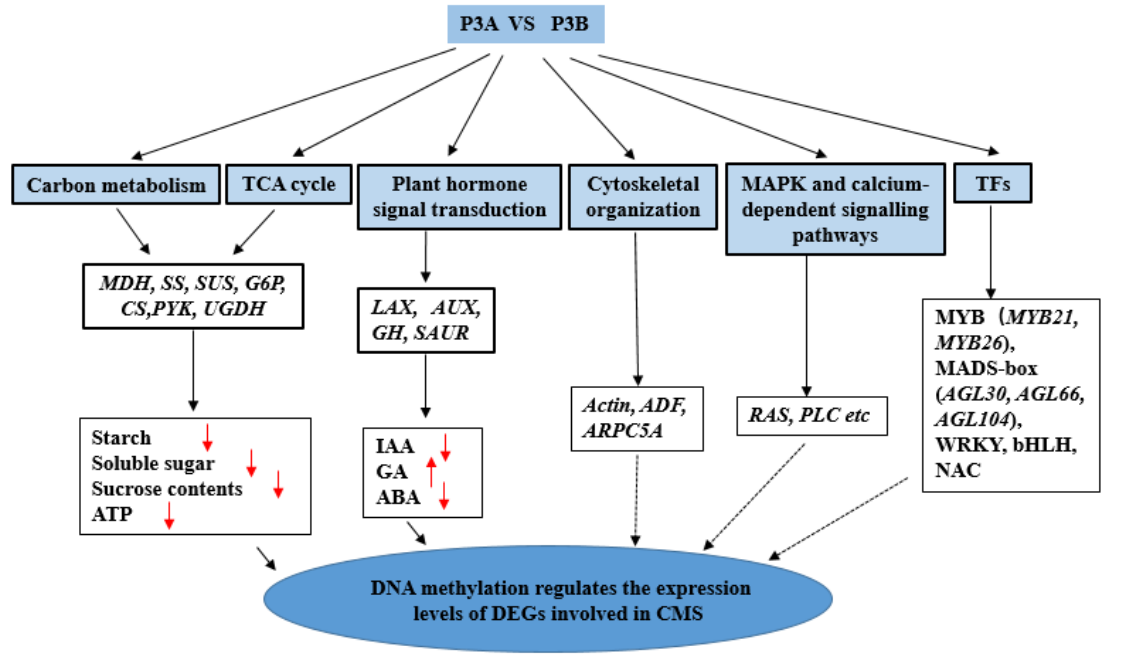
Figure 9. A model for the changes in DMGs and DEGs contributing to CMS in kenaf. Note: The upwards red arrowhead indicates that the content of this indicator is significantly increased in P3A, and the downwards red arrowhead indicates that the content of this indicator is significantly decreased in P3A. The solid line indicates that there has been sufficient and in-depth research, while the dotted line indicates that further in-depth research and verification are needed.